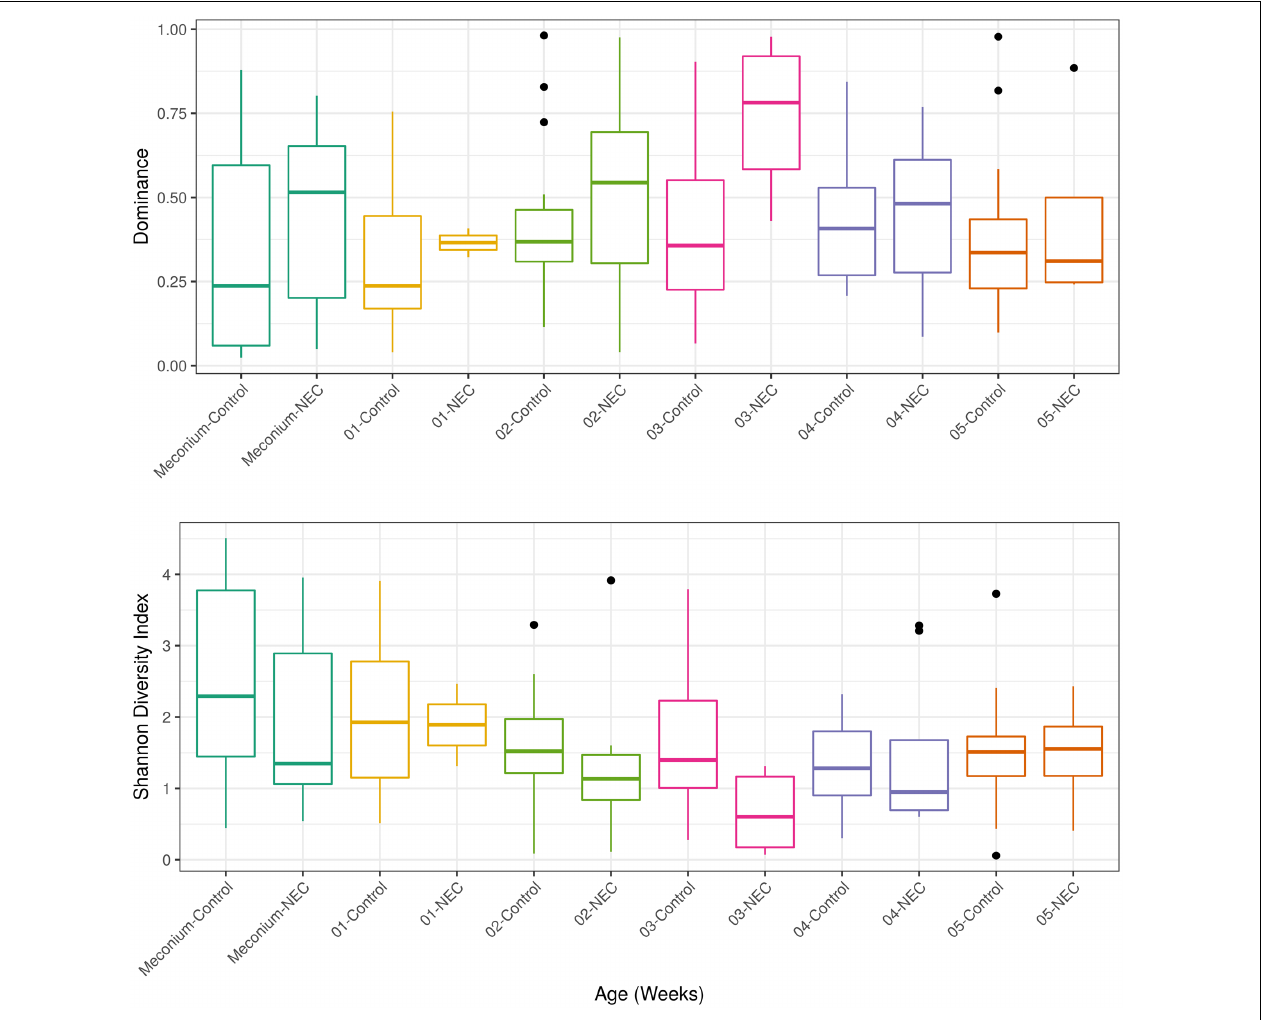
FIGURE 3 | Alpha diversity measurements of microbial communities in meconium and fecal samples from preterms diagnosed with NEC and preterms used as control without NEC diagnosis beginning with the first stool (meconium) and continuing until the 5th week of life. The upper panel presents the Dominance of microbial phylotypes. The bottom panel presents the Shannon microbial index of diversity. Boxes span the first to third quartiles; the horizontal line inside the boxes represents the median. Whiskers extending vertically from the boxes indicate variability outside the upper and lower quartiles, and the black circles indicate outliers. Samples are colored by age: Meconium (first pass stool between 0 and 4 days of life), first week (5–7 days) until the 5th